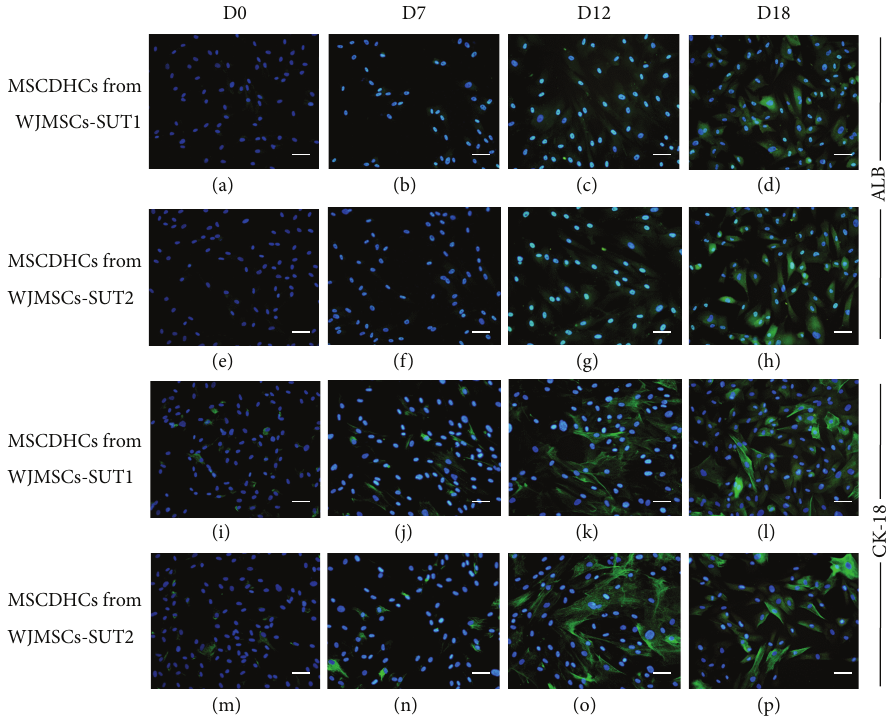
Figure 4: Hepatic-specific protein expressions of the differentiated cells after induction for 18 days. Albumin (ALB) expression analysis: MSCDHCs generated from WJMSCs-SUT1 ((a)–(d)) and WJMSCs-SUT2 ((e)–(h)) were stained with rabbit polyclonal anti-human albumin antibody following the differentiation period. For detection of cytokeratin 18 (CK-18) expression, MSCDHCs generated from WJMSCs-SUT1 ((i)–(l))andWJMSCs-SUT2((m)–(p))werestainedwithmousemonoclonalanti-humancytokeratin18antibodyfollowingthedifferentiation period. Cells nuclei were counterstained with DAPI. Original magnifications: ×200 for all pictures. Bars indicate 50 𝜇